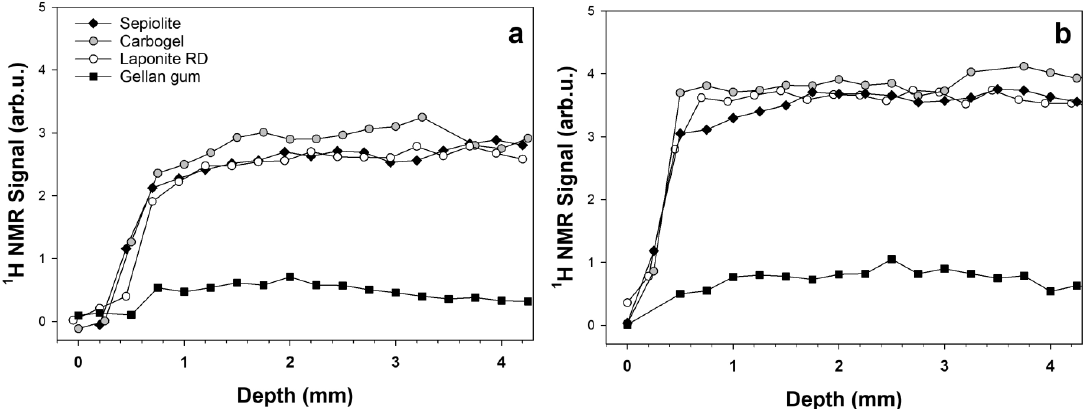
Figure 1. 1 H NMR depth profiles of water released into wall painting specimens after ( a ) 1-h and ( b ) 4-h application of Carbogel, Sepiolite, Laponite, and Gellan gum/bacteria cleaning systems.